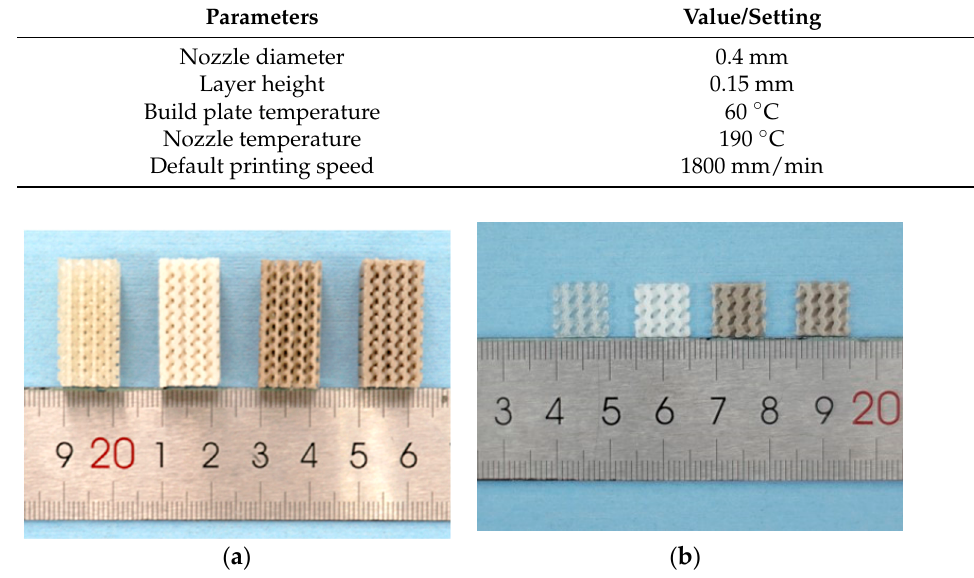
Figure 2. ( a ) Gyroid scaffolds intended for the compressive test; ( b ) Gyroid scaffolds intended for in-vitro degradation study. The material compositions of the four scaffolds (from left to right) are PLA, MgO/PLA, PGF/PLA, and (MgO + PGF)/PLA, respectively.